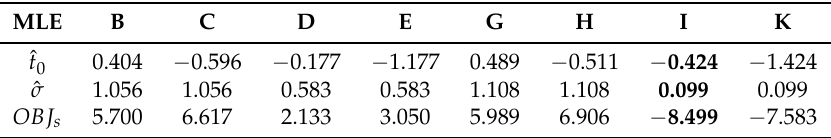
Table 1. MLE of the diffusion parameters ( t 0 , σ ) and corresponding objective function for each candidate source computed by GLAD on the toy